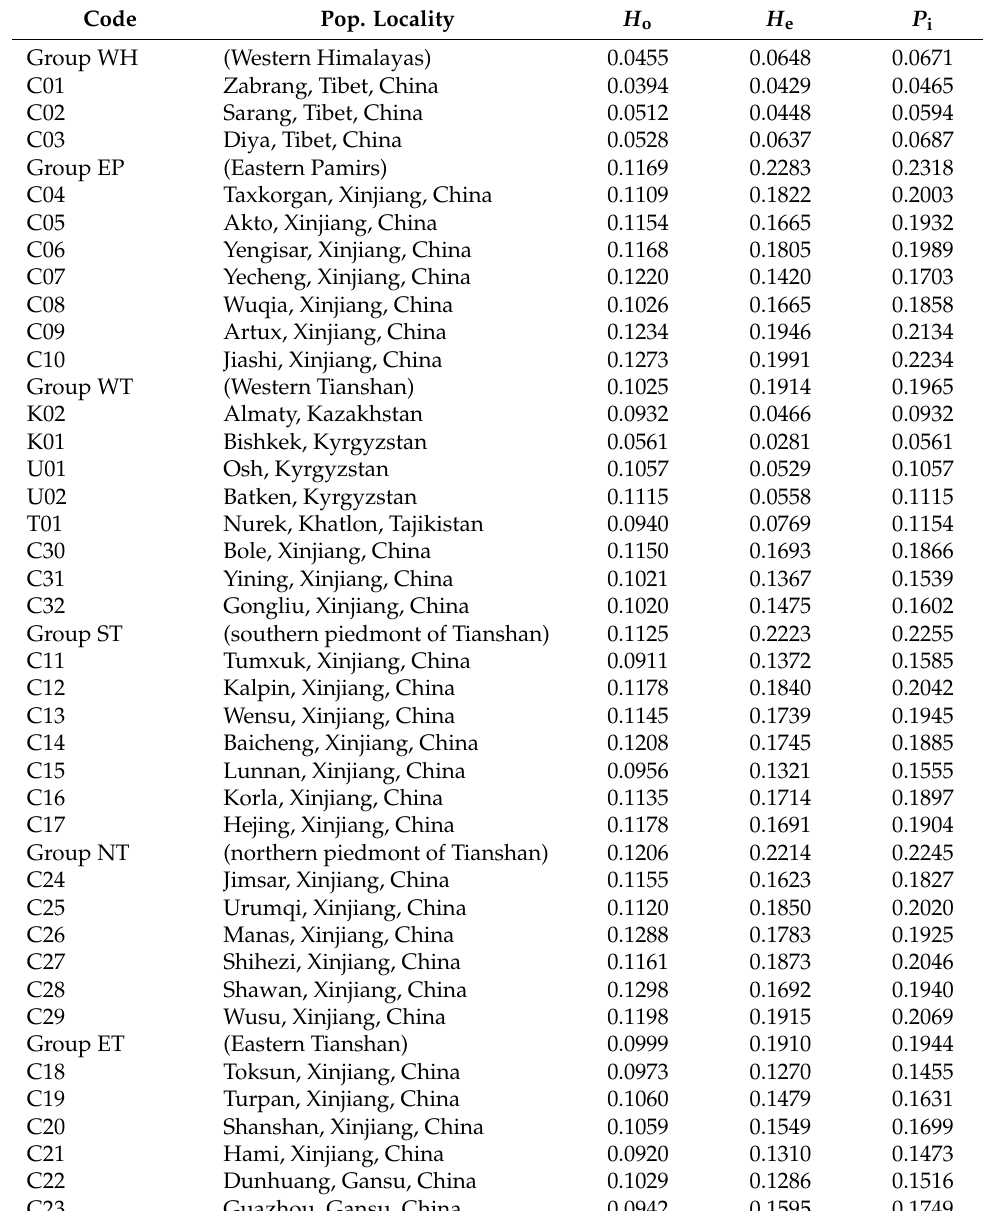
Table 1. Genetic diversity indices for natural populations of C. spinosa .